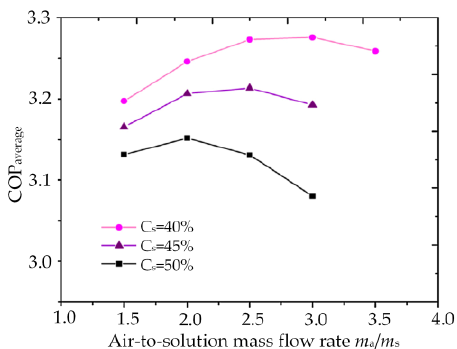
Figure 21. Effects of air-to-solution mass flow rate on the COP average of FFASHP system at different concentrations [87].